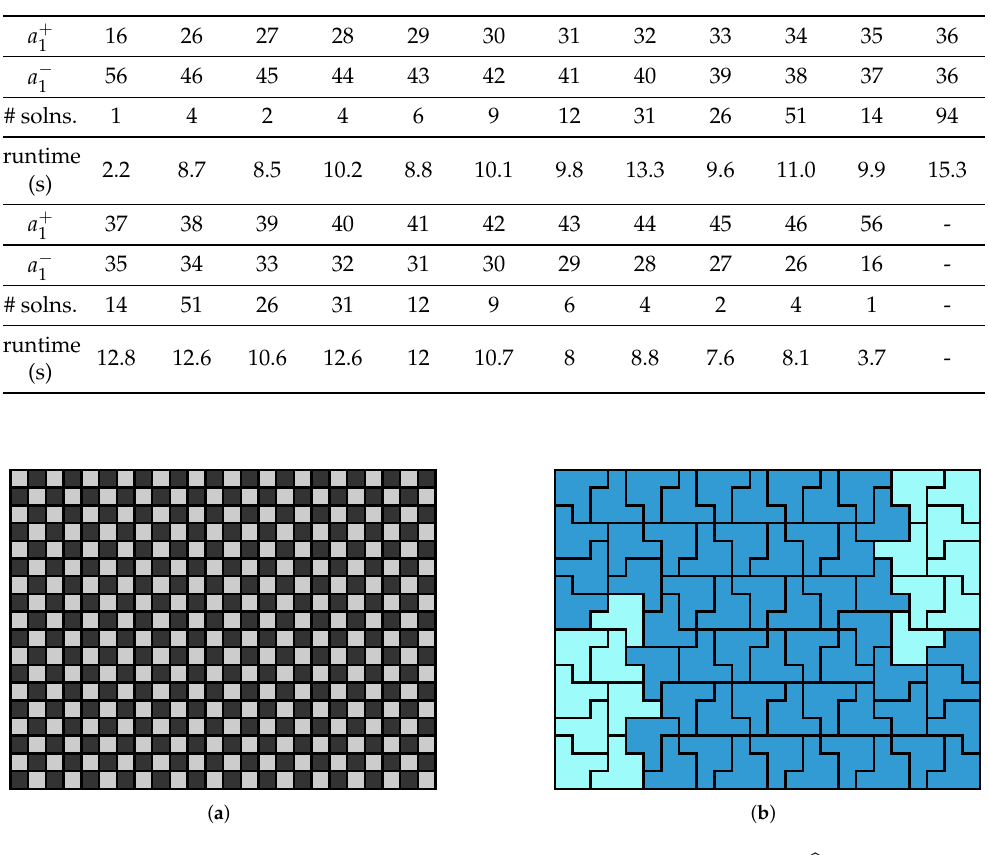
variants coloured dark-blue corresponding to the 1 ) = ( 16,56 ) (see Table , a − 1 1